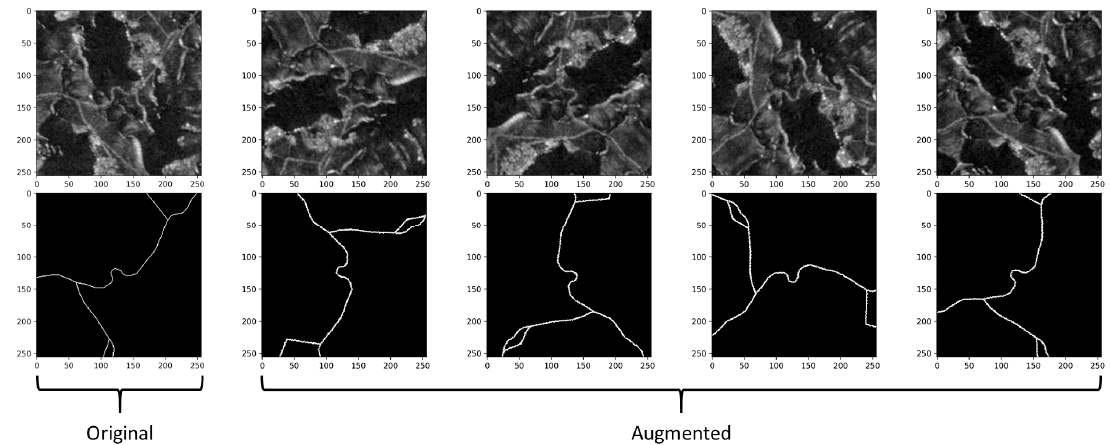
Figure 4. An example of data augmentation for an input synthetic aperture radar (SAR) patch (upper leftmost) and its corresponding reference mask (lower leftmost). Note how the augmented versions continue segments without breaking lines, using the “reflect” mode to fill gaps following rotation. Contains modified Copernicus Sentinel–1 data 2020.